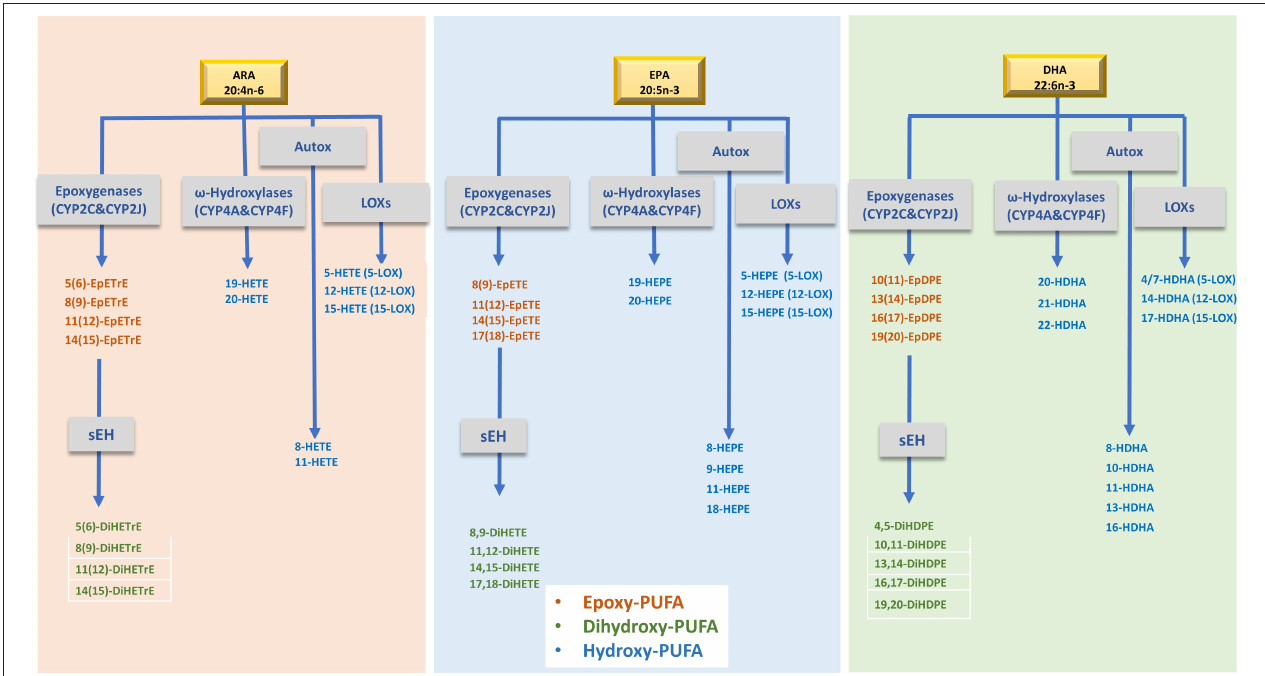
FIGURE 1 | Simplified metabolism of ARA, EPA and DHA by, LOXs and CYPs to produce the oxylipins evaluated in this study. ARA, Arachidonic acid; EPA, Eicosapentaenoic acid; DHA, docosahexaenoic acid; LOXs, lipoxygenases; sEH, soluble epoxide hydrolase enzyme; EpETrE, epoxyeicosatrienoic acid; DiHETrE, dihydroxyeicosatrienoic acid; HETE, hydroxy-eicosatetraenoic acid; EpETE, epoxyeicosatetraenoic acid; DiHETE, dihydroxyeicosatetraenoic acids; HEPE, hydroxyeicosapentaenoic acid; EpDPE, epoxydocosapentaenoic acid; DiHDPE, dihydroxydocosapentaenoic acid; HDHA, hydroxydocosahexaenoic acid. Of note, several oxylipins can be formed by different routes as well as by chemical autoxidation.